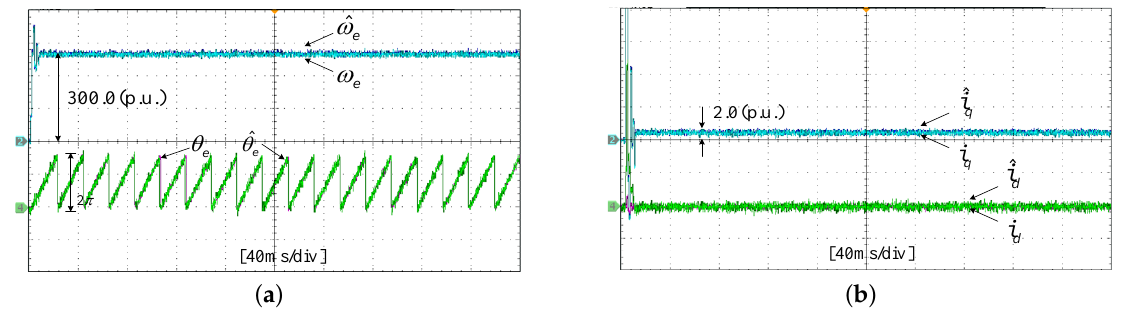
Figure 29. Experimental results of states and their estimated values. ( a ) States ω e , θ e and their estimated values ˆ ω e , ˆ θ e ; ( b ) states i d , i q and their estimated values ˆ i d , ˆ i q .